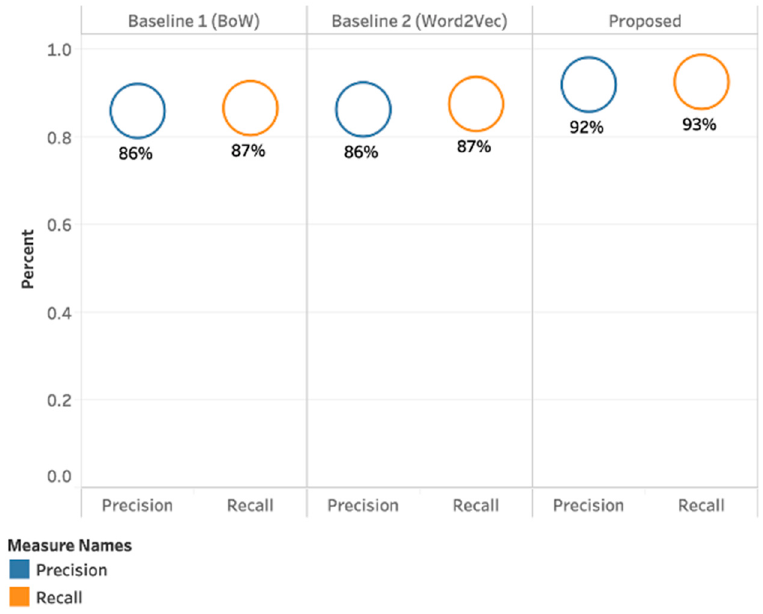
Figure 7. Precision and Recall for baseline and the proposed approach. Informatics 2020 , 7 , x